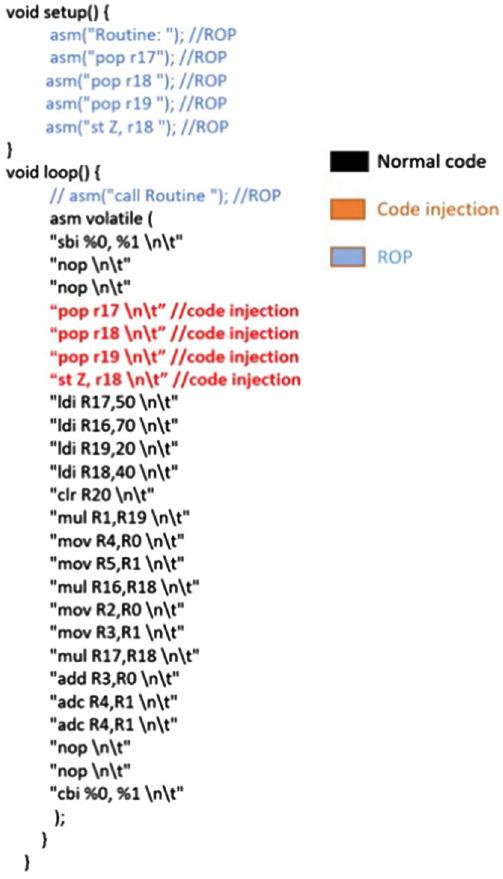
Fig. 9 Sample code for benchmark “Matrixmultiplica- tion” with color codes used to distinguish between normal and malware lines of